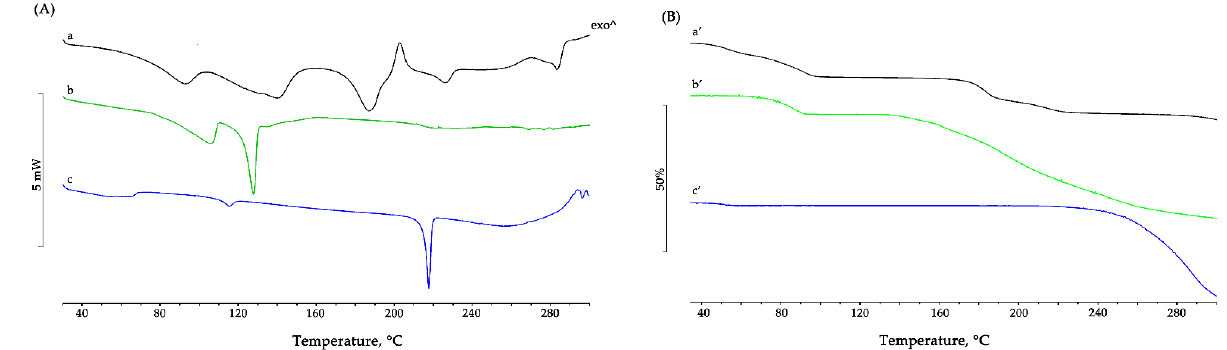
Figure 2. Thermal profiles recorded on the commercial product BBR-HCl ( a , a’ ); the salt obtained with NaLAU, BBR-L ( b , b’ ); and the salt obtained with SDS, BBR-S ( c , c’ ). Heat flow in mW for DSC curves ( A ) and mass loss in percent for TGA curves ( B ) recorded during heating program are reported on Y-axes versus temperature in °C (X-axis).